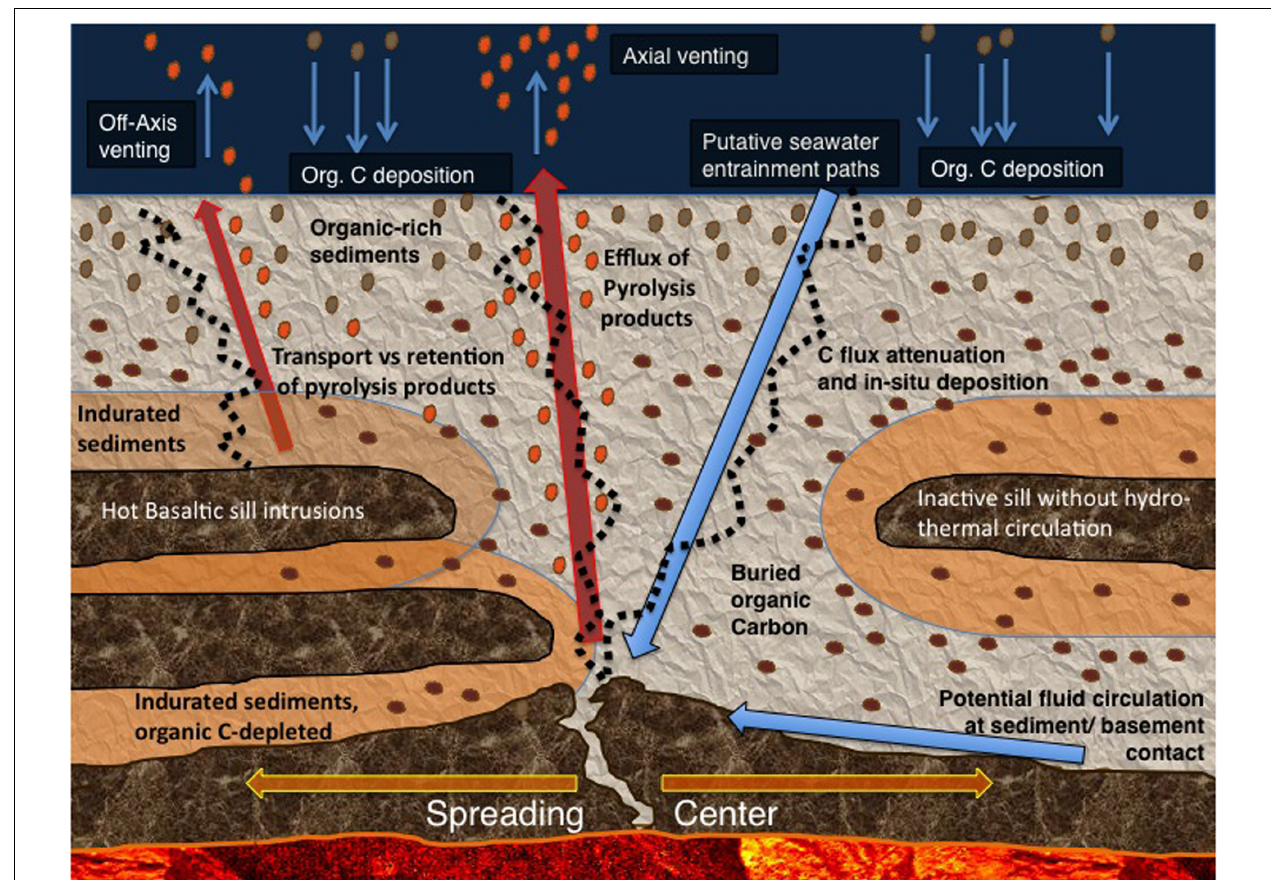
FIGURE 1 | Schematic representation of the Guaymas Basin subsurface with deep basement, sills, sediments, marine sedimentation and organic carbon input (brown drops), immobilized carbon in the sediment (dark-brown horizontal pellets), volatile